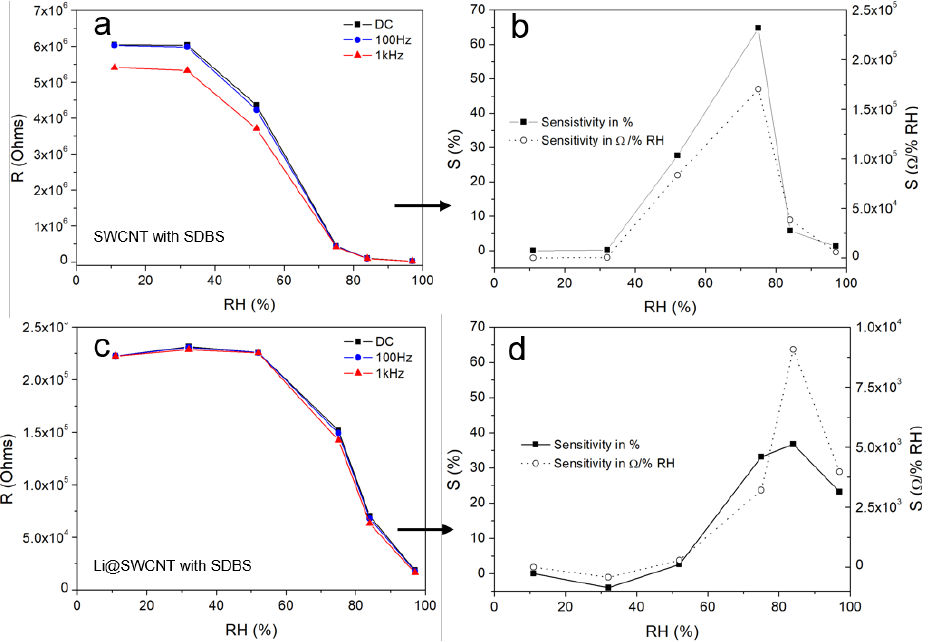
Figure 8. Resistance as a function of humidity taken at 0 Hz, 100 Hz, and 1 kHz and corresponding sensitivity at 0 Hz: of ( a , b ) undoped SWCNT/SDBS films and ( c , d ) Li@SWCNT/SDBS